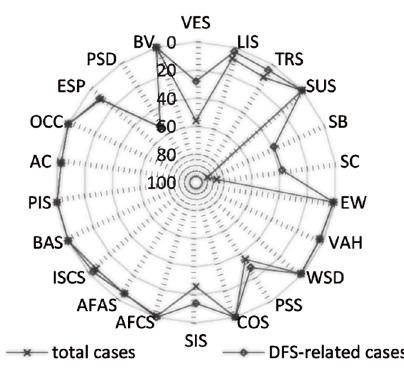
Figure 8. Incidents classified by